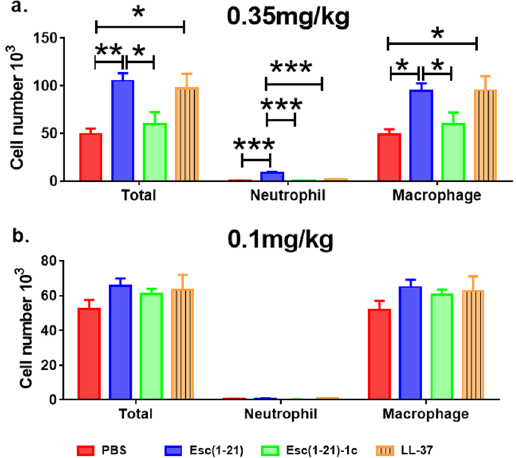
Figure 2. Effect of Esc(1–21), Esc(1–21)-1c and LL37 on the number of lung inflammatory cells in mice. The number of macrophages, neutrophils and total inflammatory cells in the BAL of mice was counted at 24 hours after peptide administration at 7 μ g/mouse (0.35 mg/kg) (panel a) or 2 μ g/mouse (0.1 mg/kg) (panel b). Results are mean ± SEM from three independent experiments; n = 4–6 mice for each group in each experiment. mice versus PBS-receiving